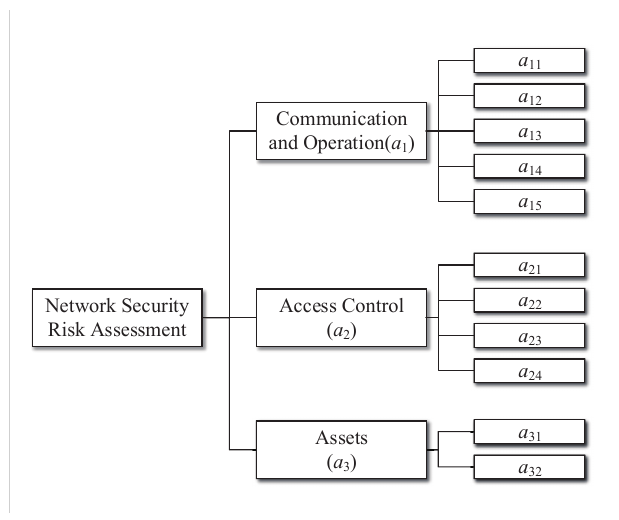
Figure 1. The hierarchical structure model